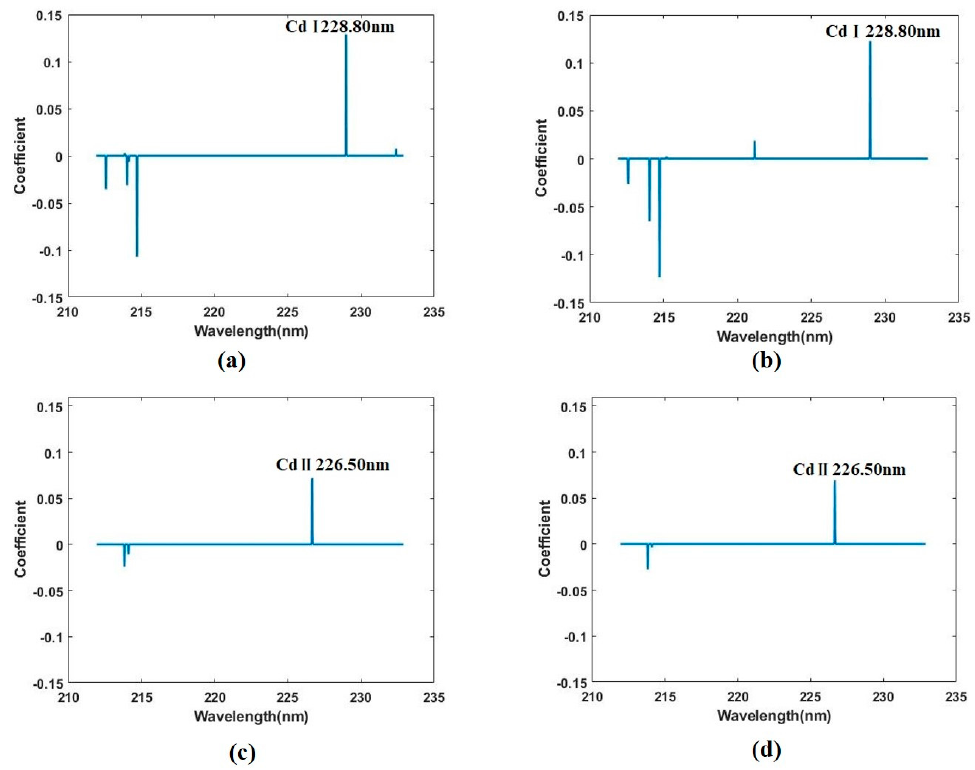
Figure 5. Least absolute shrinkage and selection operator (LASSO) coefficient. The coefficient of full spectra before pyrolysis without preprocess ( a ) and with preprocess ( b ); the coefficient of full spectra after pyrolysis without preprocess ( c ) and with preprocess ( d ).